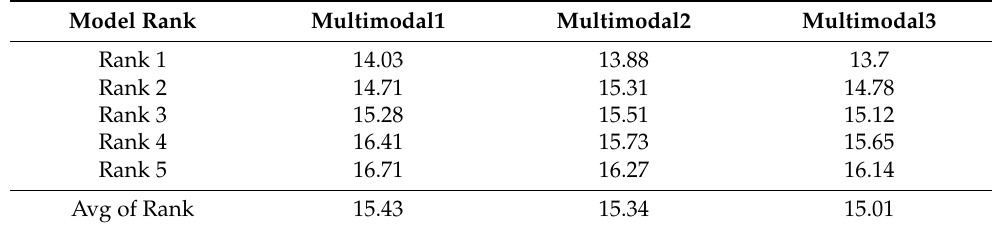
Table 3. Performance comparison of proposed models using cropped image (Test RMSE).